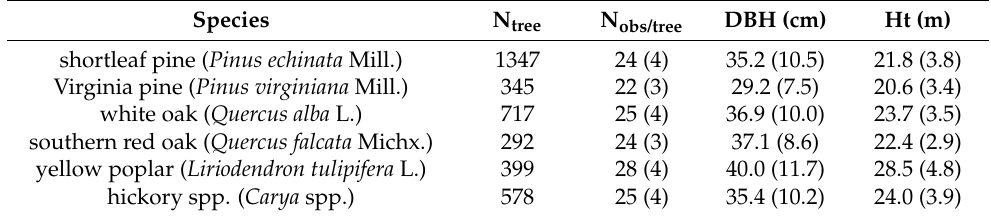
Figure 1. The average taper trends of relative diameter (d/DBH) to relative height (h/Ht) and distributions of height–DBH ratios (H–D ratios) among six species. ( a ) Taper trends, ( b ) distributions of H:D ratios. Table 1. Summary statistics of tree characteristics for the six species evaluated. N tree is the total number of sample trees, and N obs/tree is number of observations (taper points) per tree. DBH is diameter at breast height in cm, and Ht is total tree height in m. For N obs/tree , DBH and Ht, the average is given followed by standard deviation in parentheses.